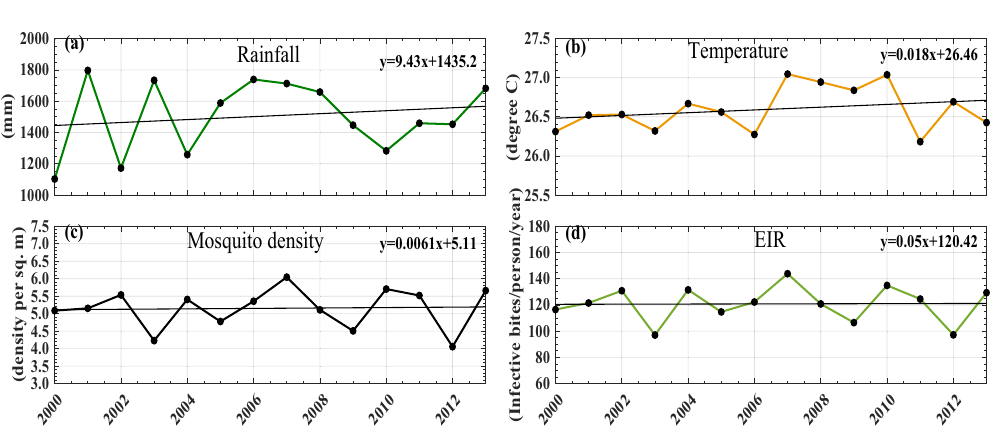
Figure 3. Trend in VECTRI-simulated annual mean. ( a ) Rainfall accumulation, ( b ) surface mean temperature, ( c ) mosquito density, and ( d ) EIR, from 2000–2013 over